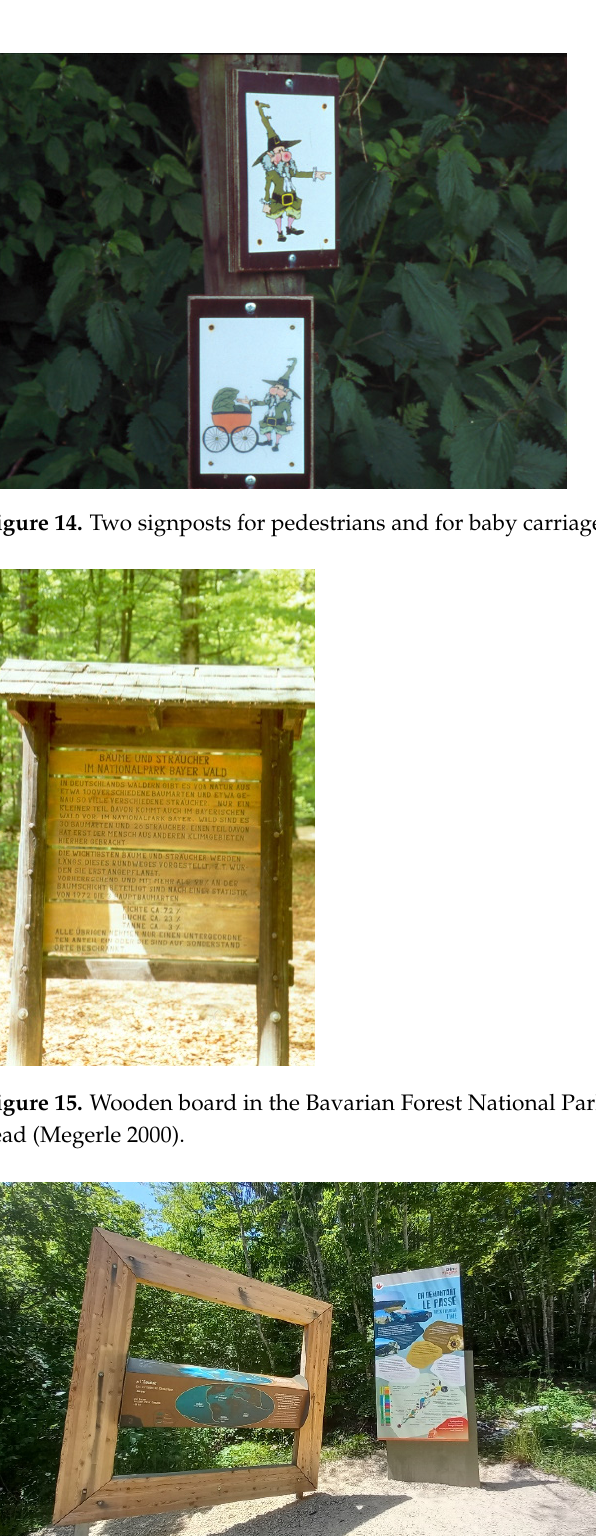
Figure 17. Path of Senses (Reutlingen, Germany). Text also in Braille (Megerle 2002).